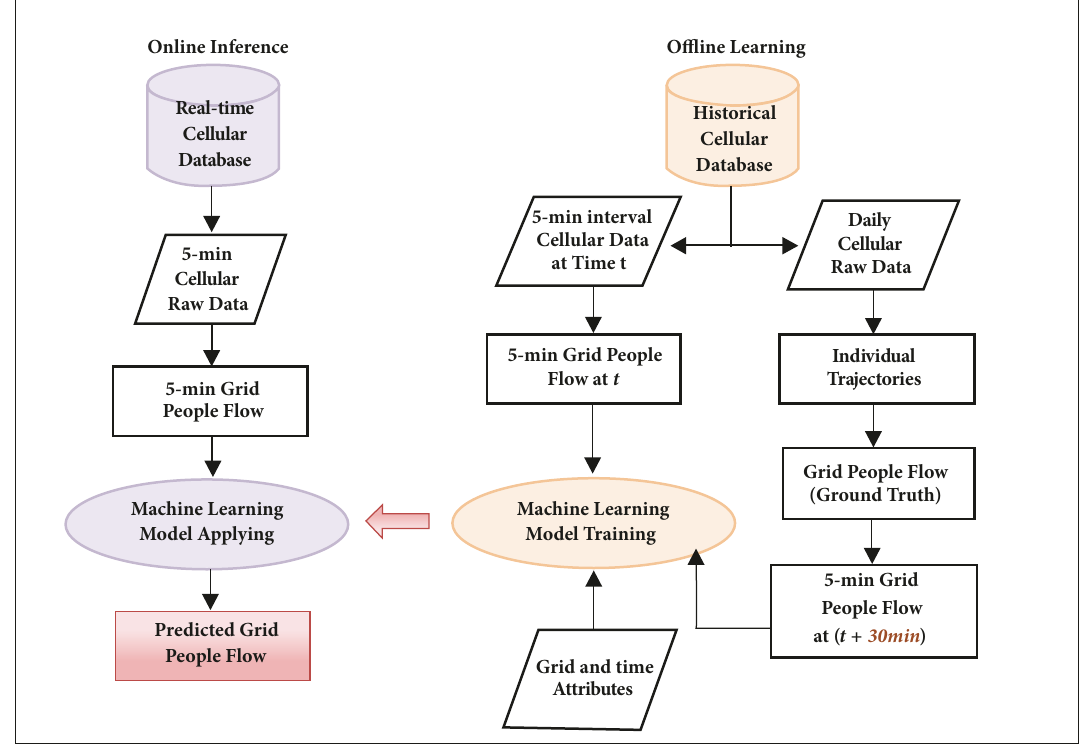
Figure 6: The work flow of data-driven